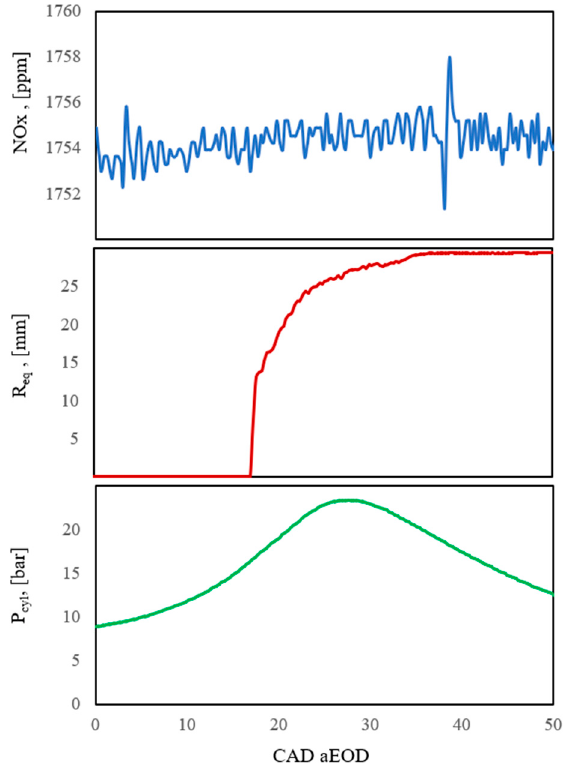
Figure 10. Examples of NOx emissions, equivalent flame radius and in-cylinder pressure experi- mental trends. The Pcyl curve has not been given with error bars because the sensor’s accuracy is quite low (see Section 2.1, Optical Access Engine). The NOx curve has not been given with error bars because it would be difficult to discern the trend.